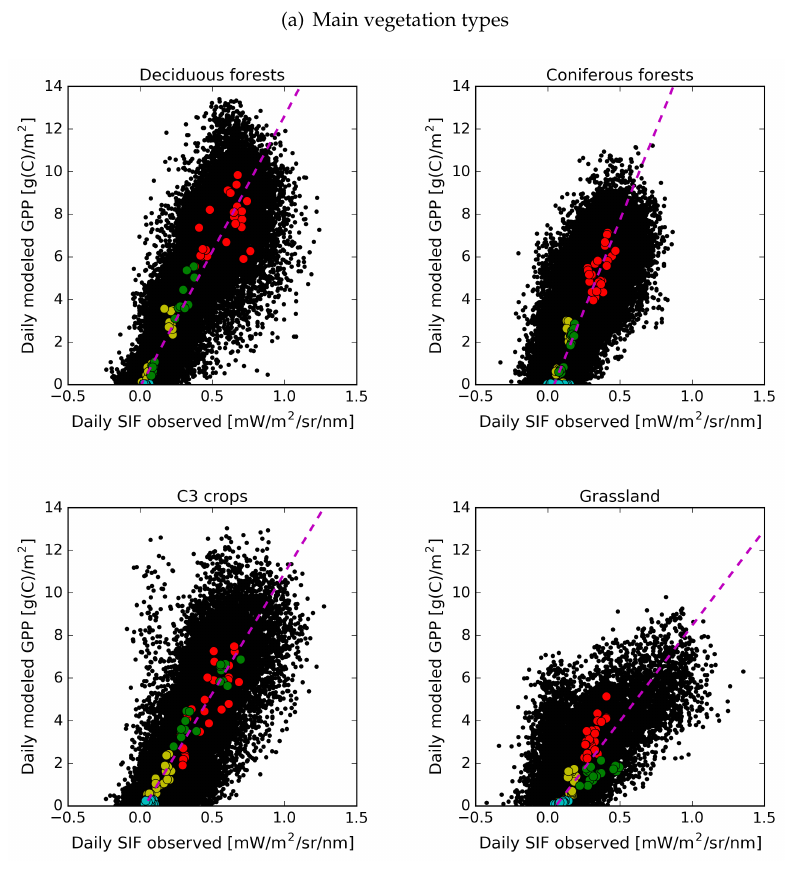
Figure 10. Pixels where at least 50% is covered by a single vegetation type (deciduous forests, coniferous forests, C3 crops, grassland, ( a ) used to investigate the relationship between the analyzed GPP and the observed SIF ( b ). Spatial averages are indicated by colored circles depending on the season: summer in red (June-July-August), autumn in yellow (September-October-November), winter in blue (December-January-February) and spring in green (March-April-May). Dashed purple lines represent the regression with the coefficients and statistics shown in Table